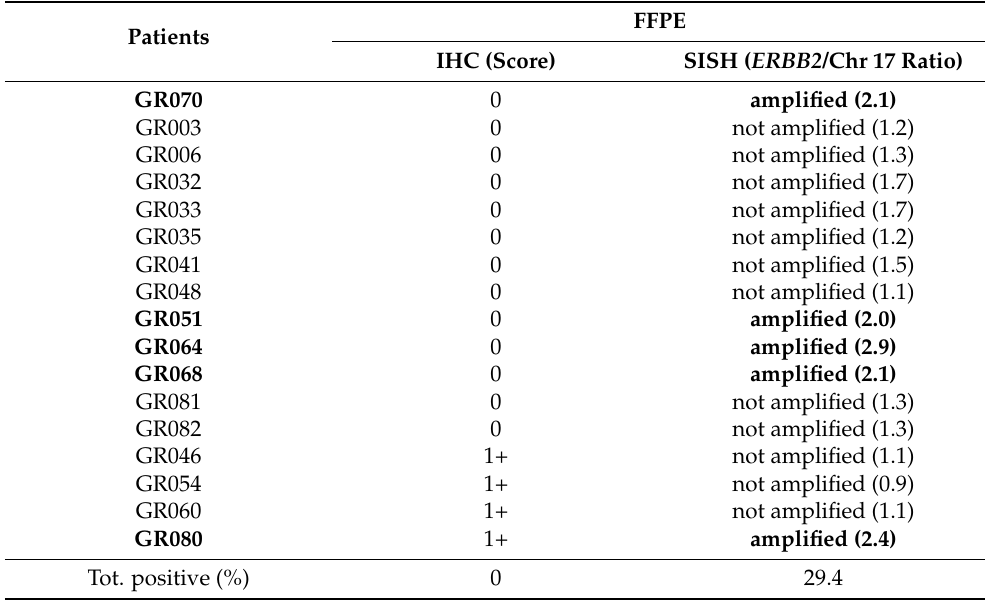
Table A1. HER2/ ERBB2 status of HER2 0–1+ retrospective patients based on